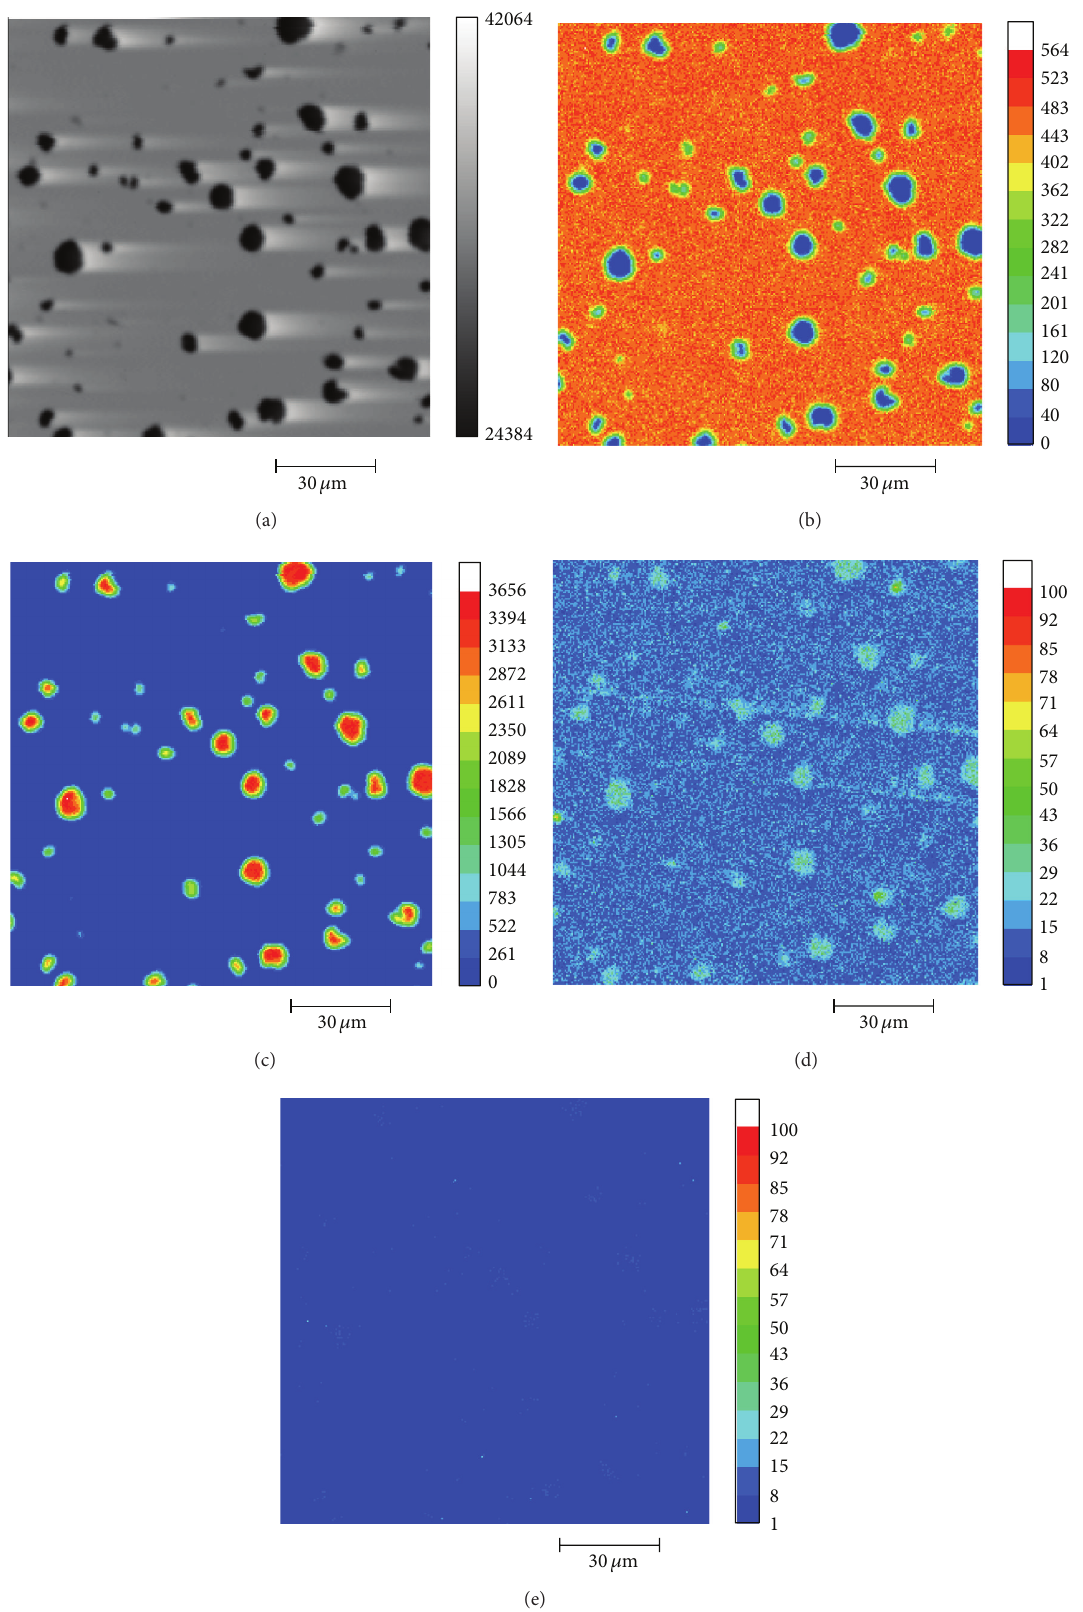
Figure 10: Elemental distribution analyzed by EPMA on the surface of ductile cast iron passivated in simulated cooling water (100,000 ppm NaNO 2 ) at 25 ∘ C for 72 hours; (a) SEM image, (b) Fe, (c) C, (d) O, and (e)